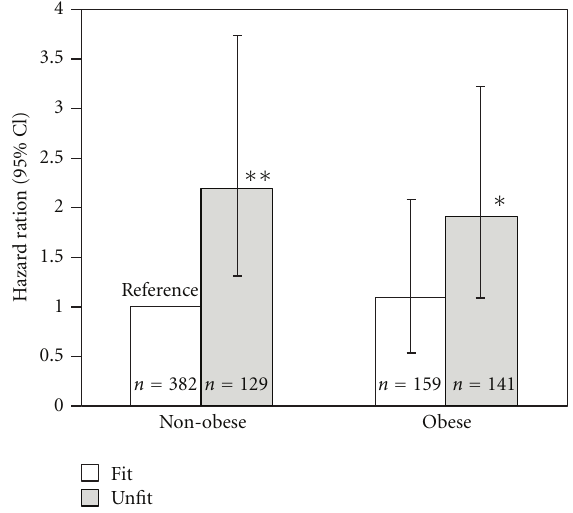
Figure 2: Multivariate hazard ratios for all-cause mortality by obe- sity status and fitness level. Each bar represents the relative risk after adjustment for age, ethnicity, hypertension, hypercholesterolemia, family history of coronary artery disease, and cardiovascular medication use with the relative risk of nonobese (BMI 18.5– 29.9 kg/m 2 ) and fit ( > 9 METs) set at 1.0. Grey bars represent unfit (lowest third of distribution) and dark bars fit (upper two-thirds of distribution). Error bars represent 95% confidence intervals. Di ff ered from reference: ∗ P < 0 . 05; ∗∗ P < 0 .